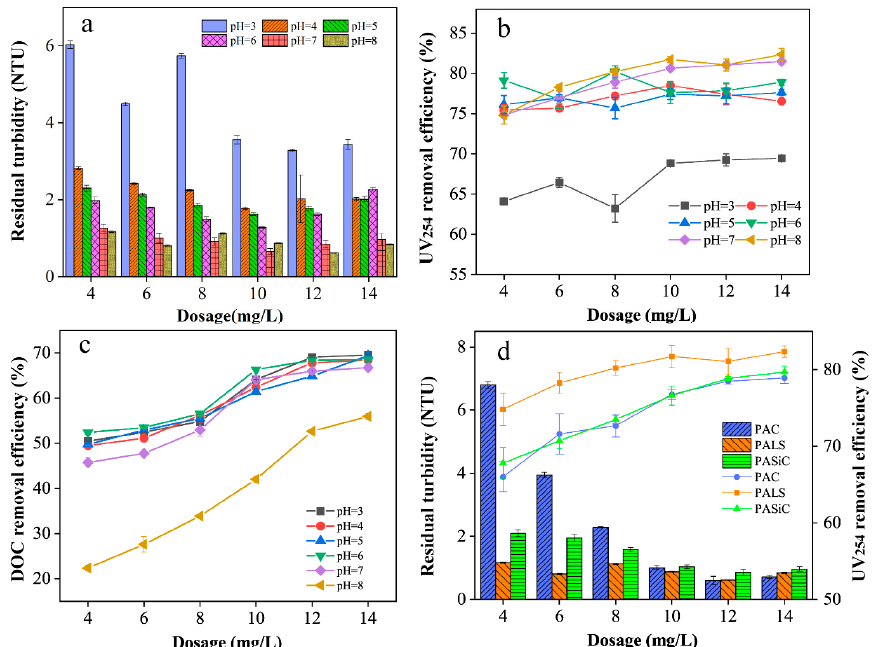
Figure 5. Effect of dosage and pH on residual turbidity ( a ), UV 254 removal ( b ), and DOC removal ( c ) with PALS and comparison between PAC, PASiC, and PALS on residual turbidity and UV 254 removal ( d ).